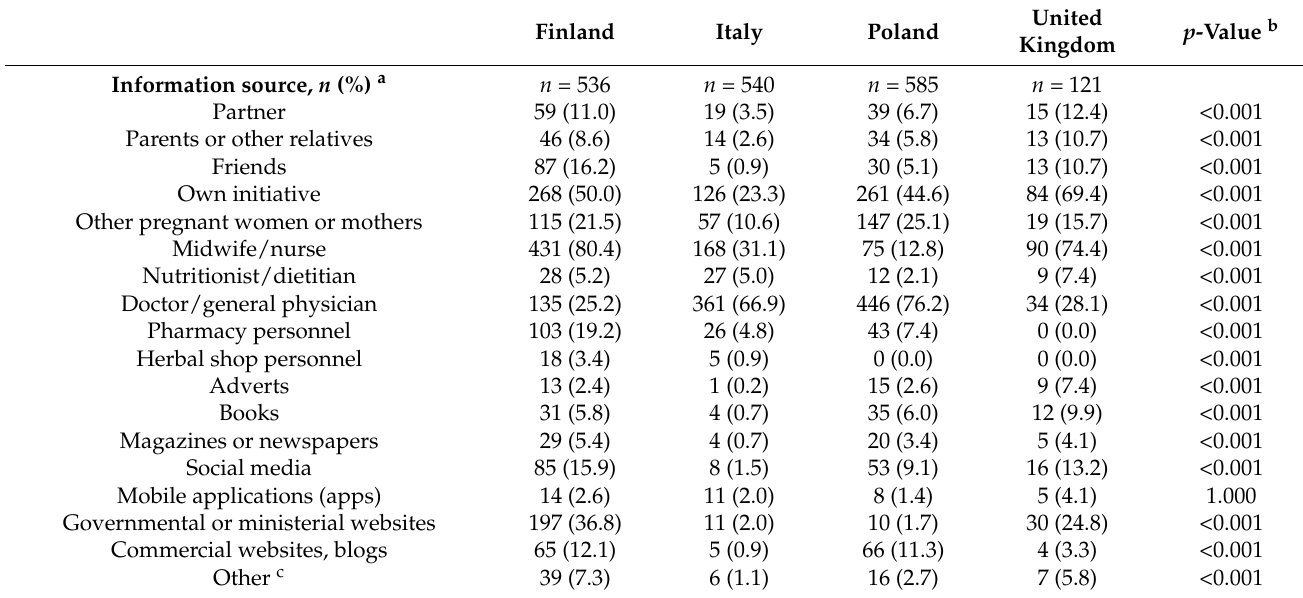
Table 3. Information sources reported by pregnant women in four European countries that influence their food supplements